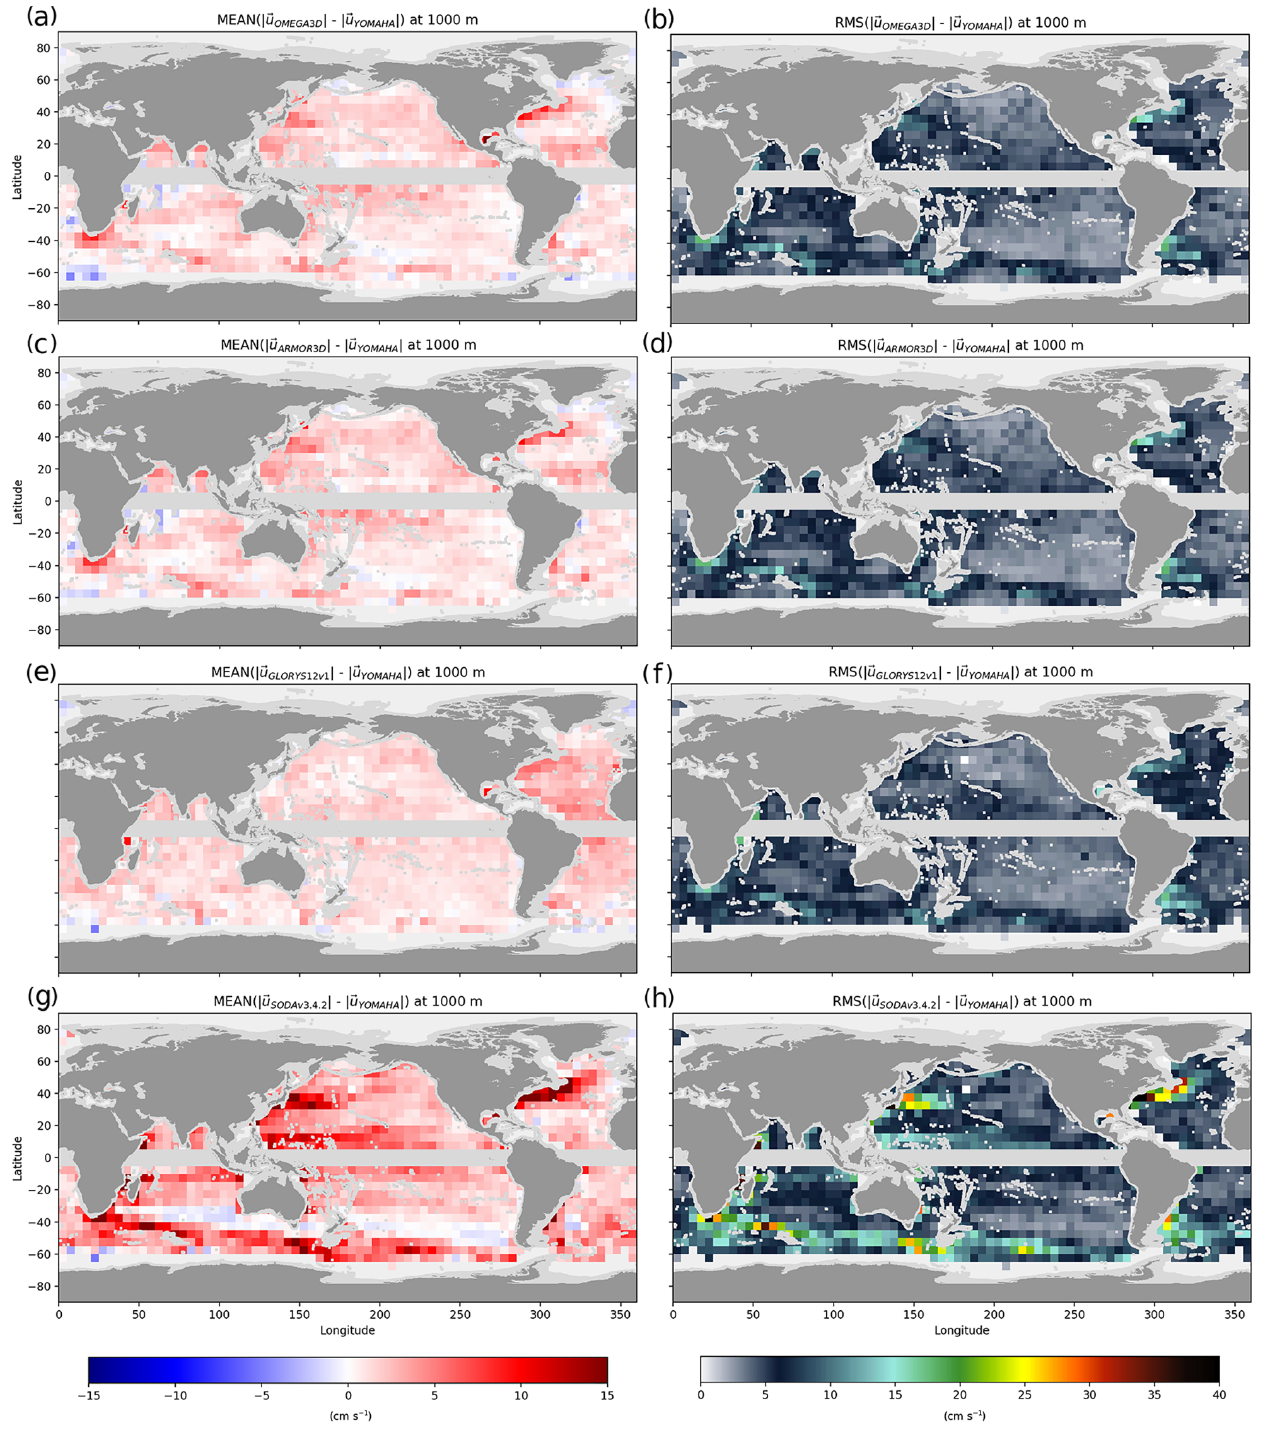
Figure 6. Mean and root mean square differences between OMEGA3D (a, b) , ARMOR3D (c, d) , GLORYS12v1 (e, f) and SODAv3.4.2 (g, h) velocities at 1000m depth and co-located YOMAHA